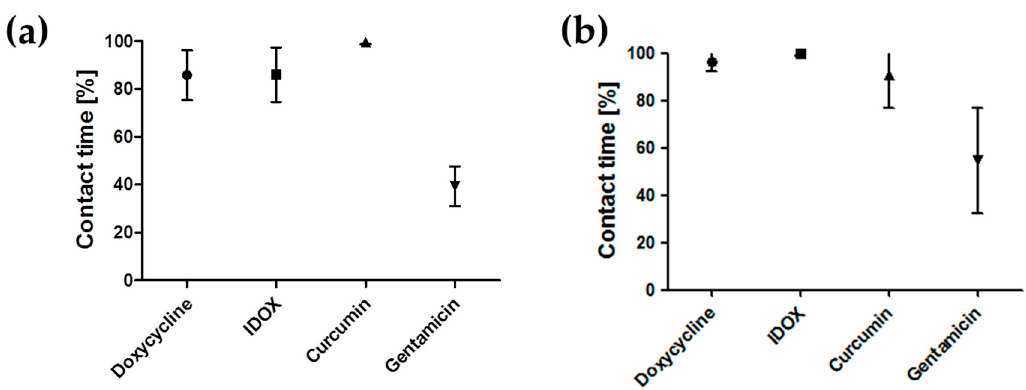
Figure 4. Average contact time between anti-amyloidogenic molecules and the two different polymorphs of A β 42 fibrils, 2MXU ( a ) and 5OQV ( b ) during the MD simulation. The contact time is the amount of time (as a percentage) during which the molecule is in contact with the fibril. The 5 ns window is meant to exclude sporadic contacts due to the high simulated concentration.